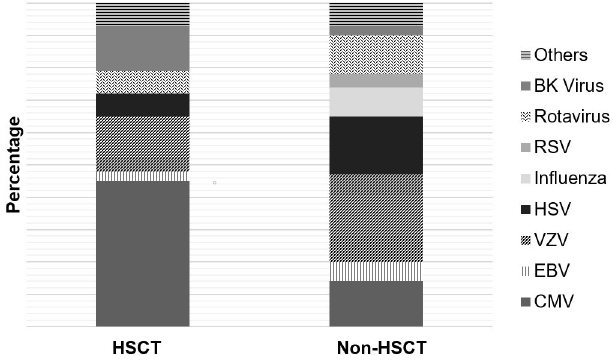
Fig 2. Distribution of viruses in participants with or without